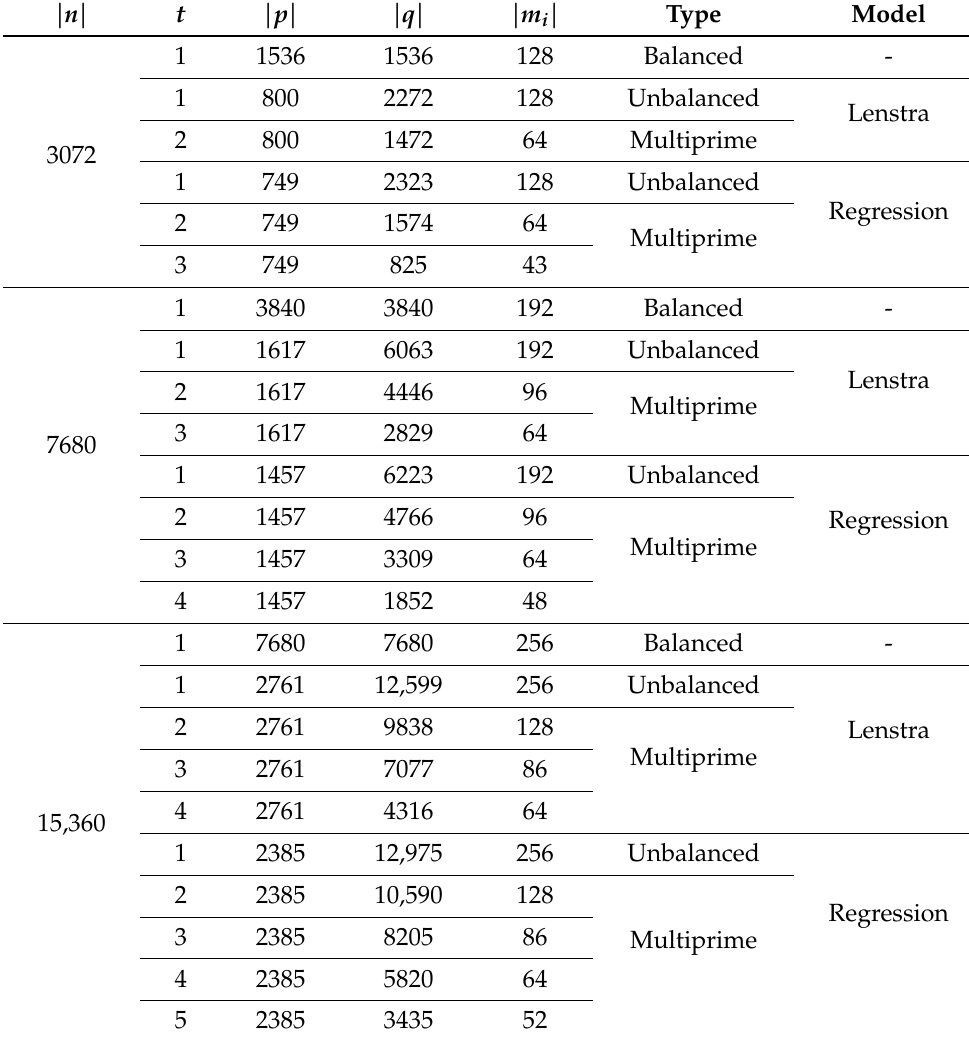
Table 3. Joye–Libert parameters’ size.r.